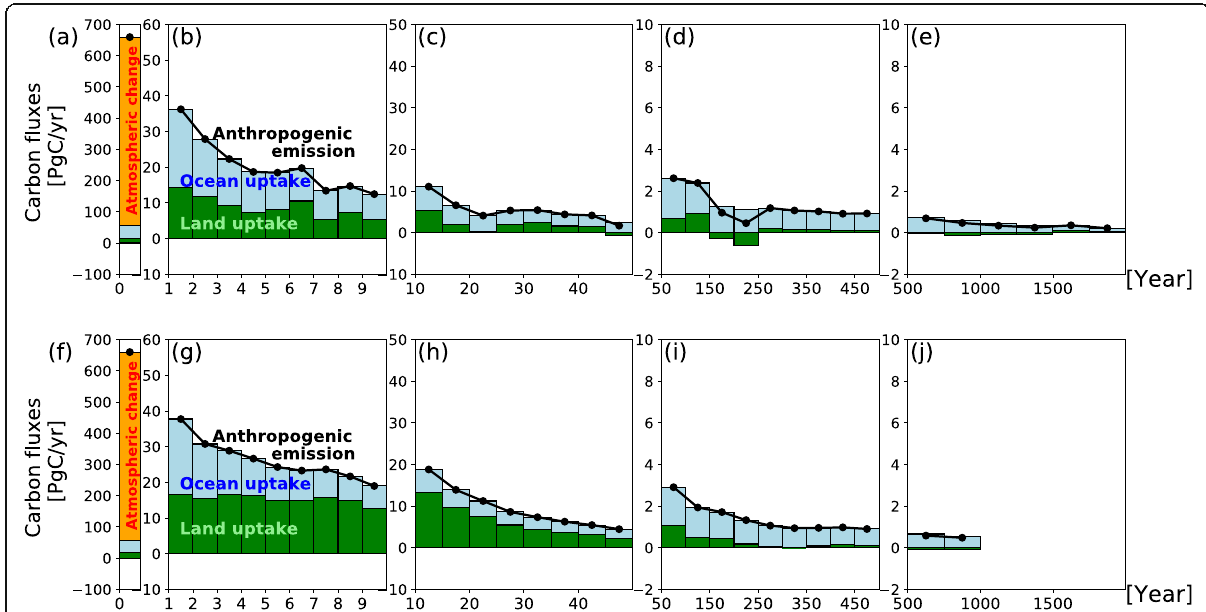
Fig. 2 Changes in atmospheric carbon (C) pool, annual land/ocean C uptake, and diagnosed anthropogenic emission in the FULL 2 × CO2 experiments: the 2000 years simulation by MIROC-ESM (top) and the 1000 years simulation by MIROC-ES2L (bottom). The annual C emission is diagnosed as the sum of C changes in the atmosphere, land, and the ocean, and presented in the figure as black dotted lines. Color bars represent changes in C storages of atmosphere (orange) and annual C uptake by ocean (light blue) and land (green). In panels c and h , d and i , and e and j , the annual C fluxes were calculated as the averages of 5-, 25-, and 250 year intervals,